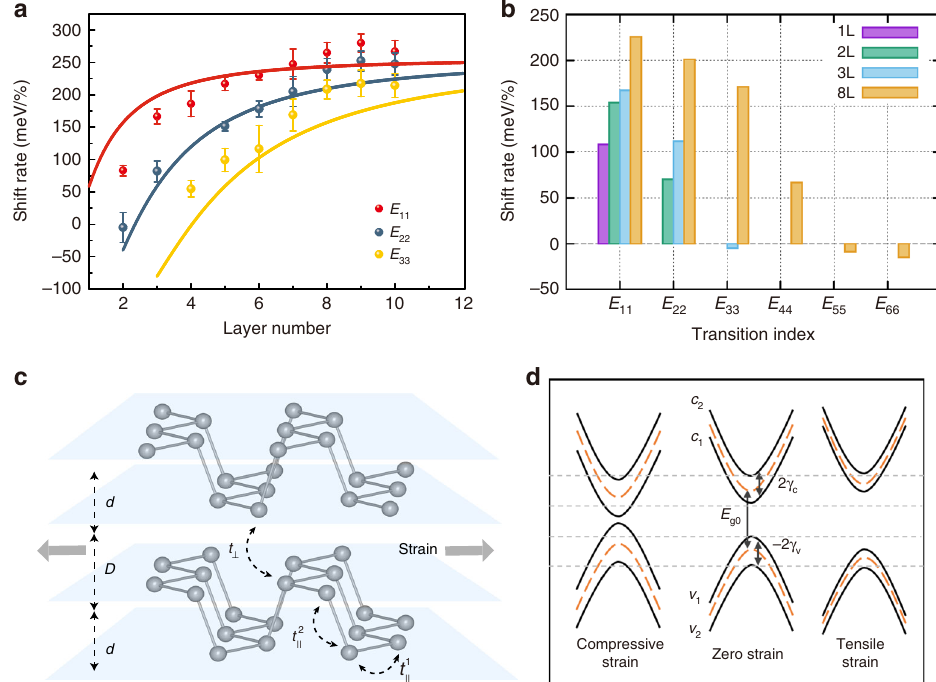
Fig. 3 Layer and subband index dependence of the biaxial strain effect. a Averaged shift rates of E 11 , E 22 , and E 33 peaks as a function of layer number in 2 – 10L BP. The solid curves are fi tted to the data using the tight-binding model shown in the text. The error bar is de fi ned from the data spread of multiple samples. For each layer, at least three samples were measured. b DFT calculated shift rates for 1L, 2L, 3L, and 8L BP induced by in-plane biaxial strain. c Illustration of two in-plane hoping parameters ( t 1 jj and t 2 jj ) and one out-of-plane hopping parameter ( t ⊥ ) in a 2L BP. d is the height of an individual layer and D is the gap between two layers. When biaxial in-plane tensile stain is applied, the average distance between two layers ( D + d ) decreases due to Poisson effect, while the gap ( D ) increases accompanied by a stronger decrease of d (see Supplementary Fig. 9). d Schematic illustration of the band structure evolution of a bilayer BP under tensile and compressive strain. The orange dashed curves are the bands for a monolayer BP. The change of subband splittings causes the shift rate of E 22 smaller than that of E 11 . Layered materials governed by van der Waals (vdW) interactions offer opportunities for interlayer tuning of the materials ’ properties. Here, the authors demonstrate that in-plane tensile strain can effectively tune the vdW interactions of few- layered black phosphorus and weaken its interlayer coupling even though the sample shrinks in the vertical